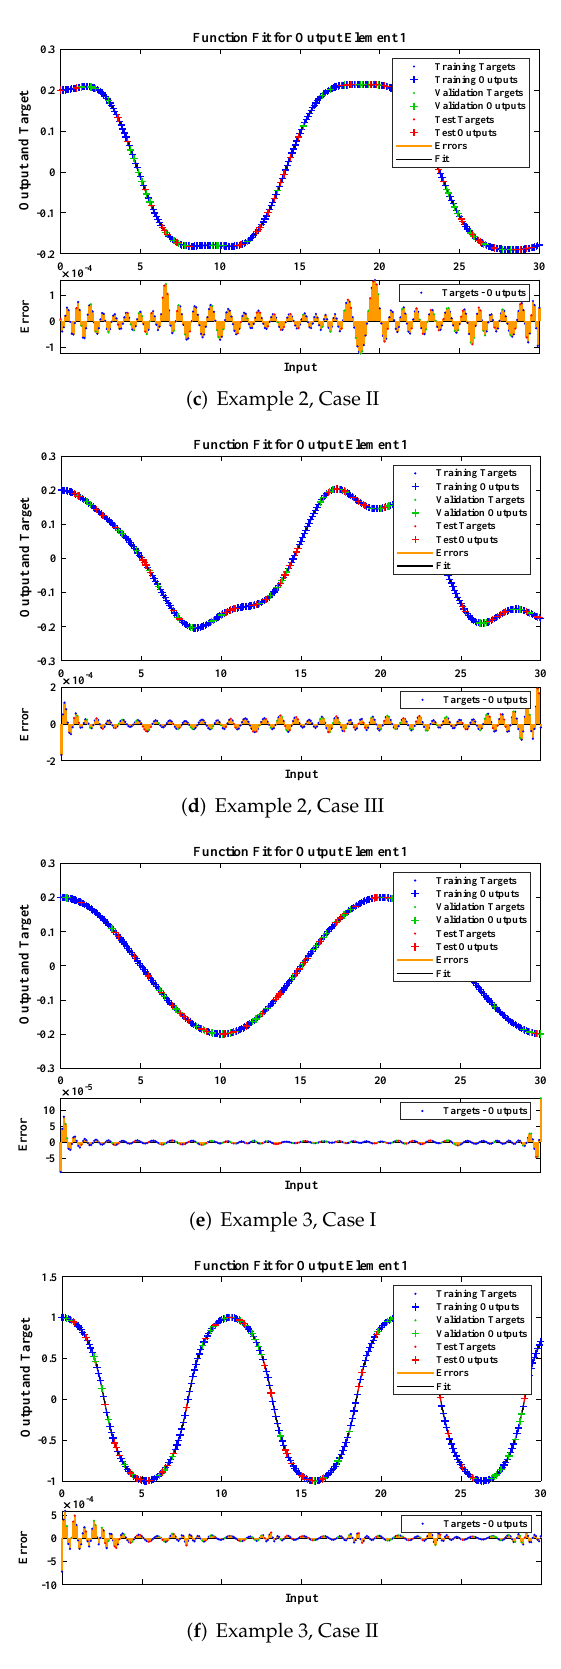
Figure 10. Analysis of the fitness plot by the LM-NN algorithm for different